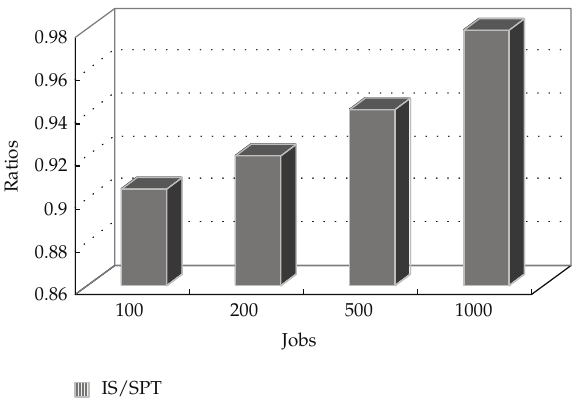
Figure 2: Ratios of IS/SPT with m (cid:9)